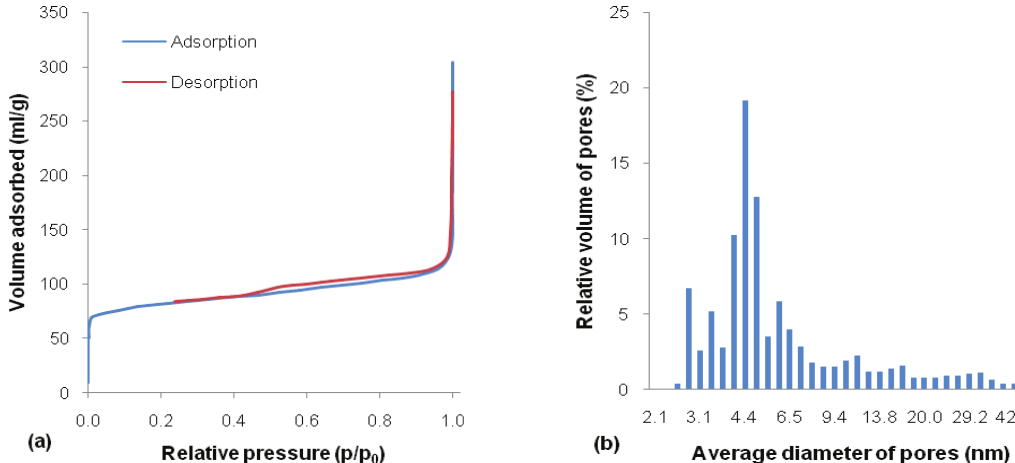
Figure 3. (a) Nitrogen adsorption/desorption isotherms at 77 K; (b) Pore size distribution of H